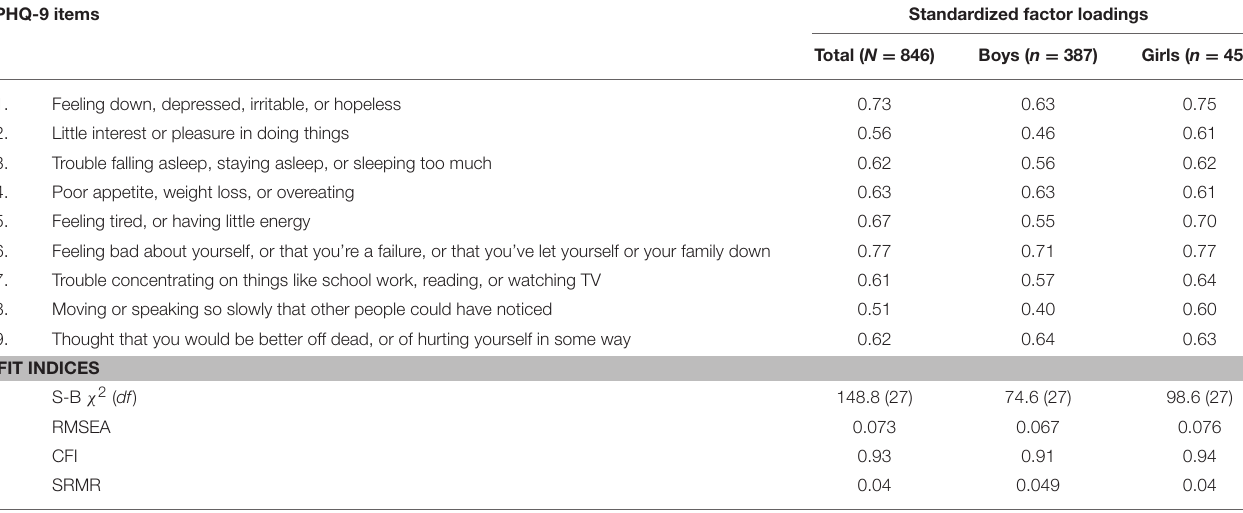
TABLE 4 | Confirmatory factor analysis for a single-factor solution for the PHQ-9 items; total sample and by gender. PHQ-9 items